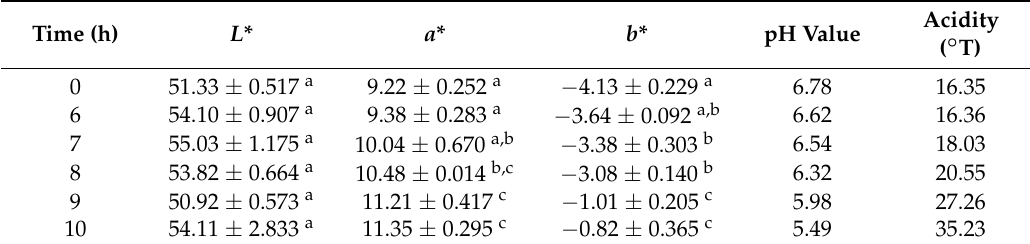
Table 3. Color parameters, pH value, and acidity of the pH-sensing film immersed in milk at different time